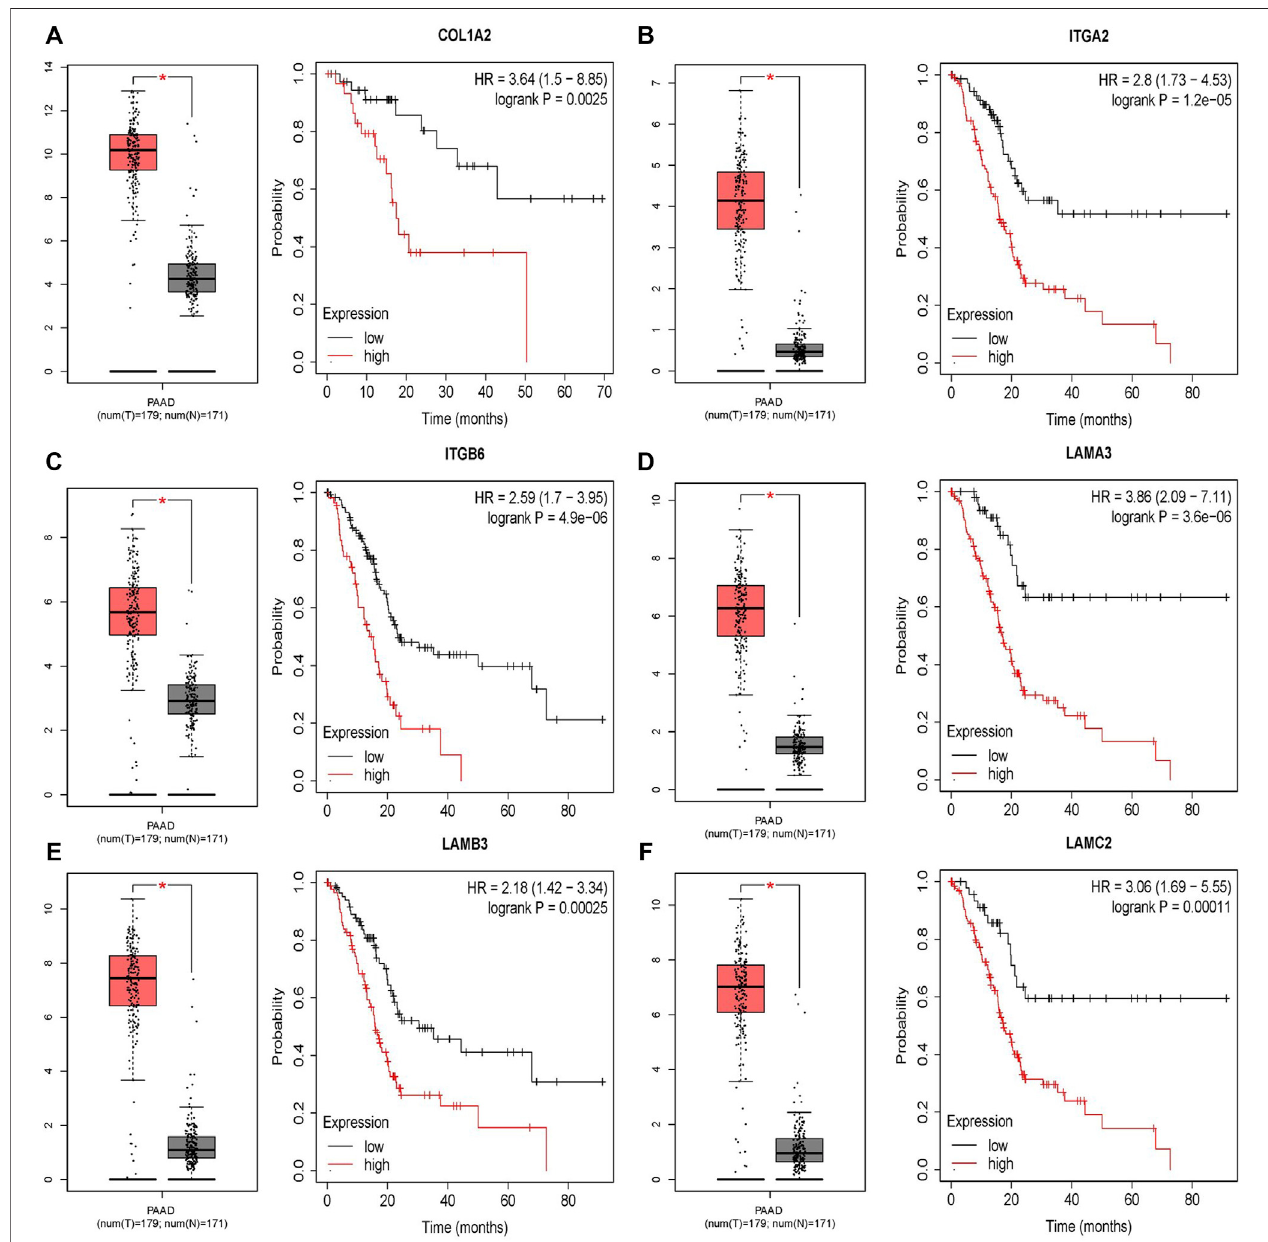
FIGURE 4 | Survival analysis results of six DEGs. (A – F) Differential expression and survival analysis of the six selected genes via the GEPIA database. From the abovementioned fi gures, it was found that these six genes were differentially expressed in the normal group and cancer group and obviously reduce the OS of patients. OS, overall